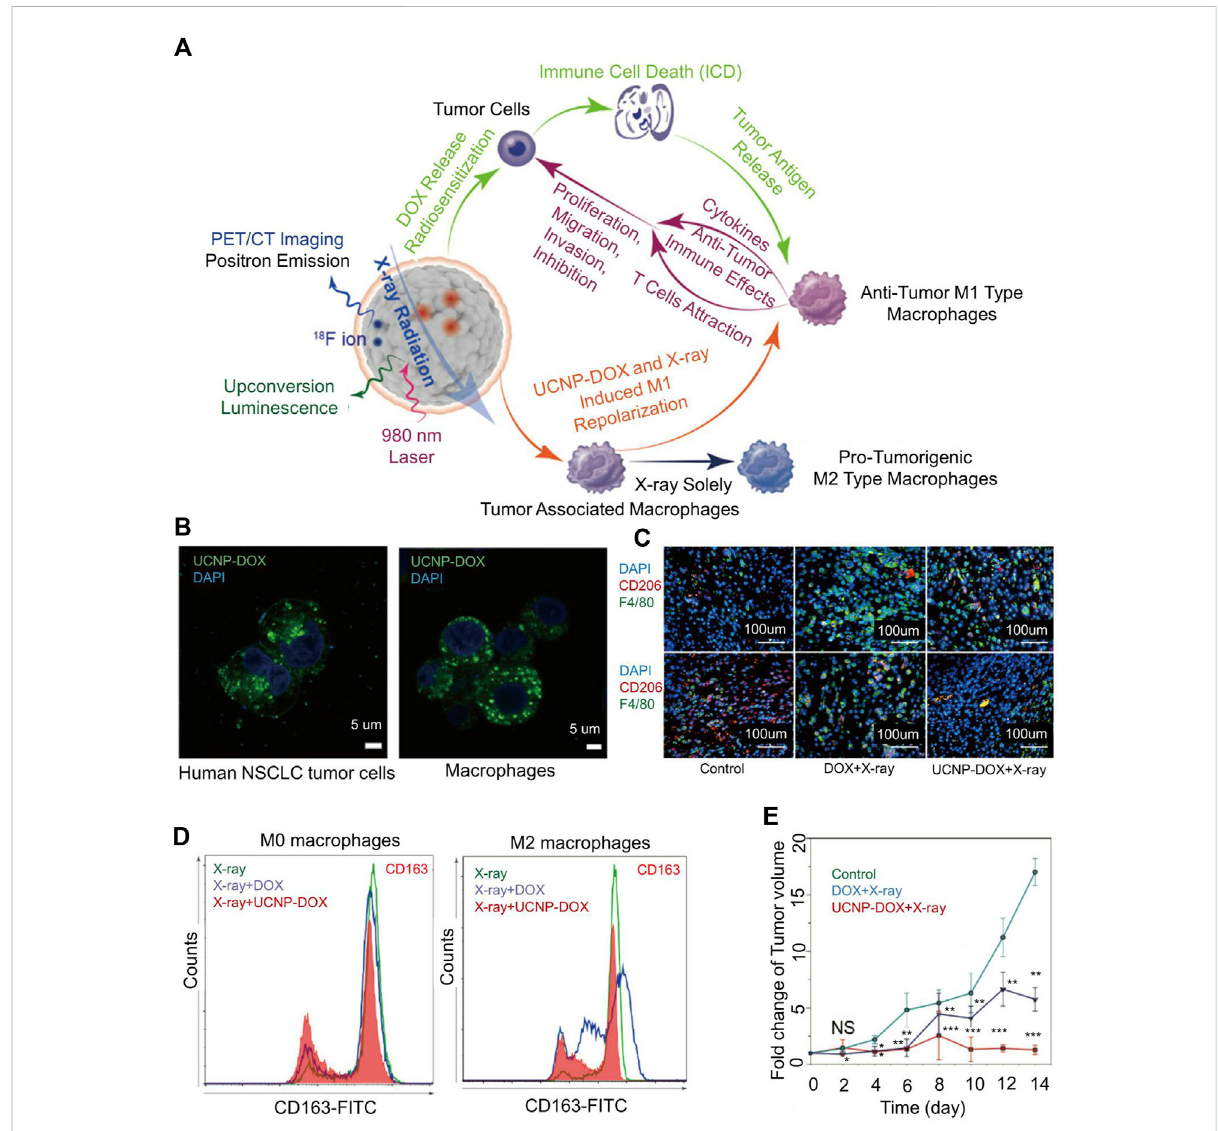
FIGURE 3 Mesoporous Bi-containing radiosensitizer to repolarize TAMs and boost abscopal effect. (A) The schematic of mesoporous Bi-containing radiosensitizer. (B) Confocal images of internalization of nanoparticles by lung cancer cells and macrophages. (C) After enhanced chemoradiotherapy of upconversion nanophosphor (UCNP) loaded with doxorubicin (UCNP-DOX) and X-ray, the tumor tissues showed intense CD68 and weak CD206 signals, showing the increased M1 macrophage level and down-regulated M2 macrophage level. (D) Polarization of macrophages in different treatment groups. (E) Fold change of tumor volume in all groups. Reproduced with permission from (Qin et al.,